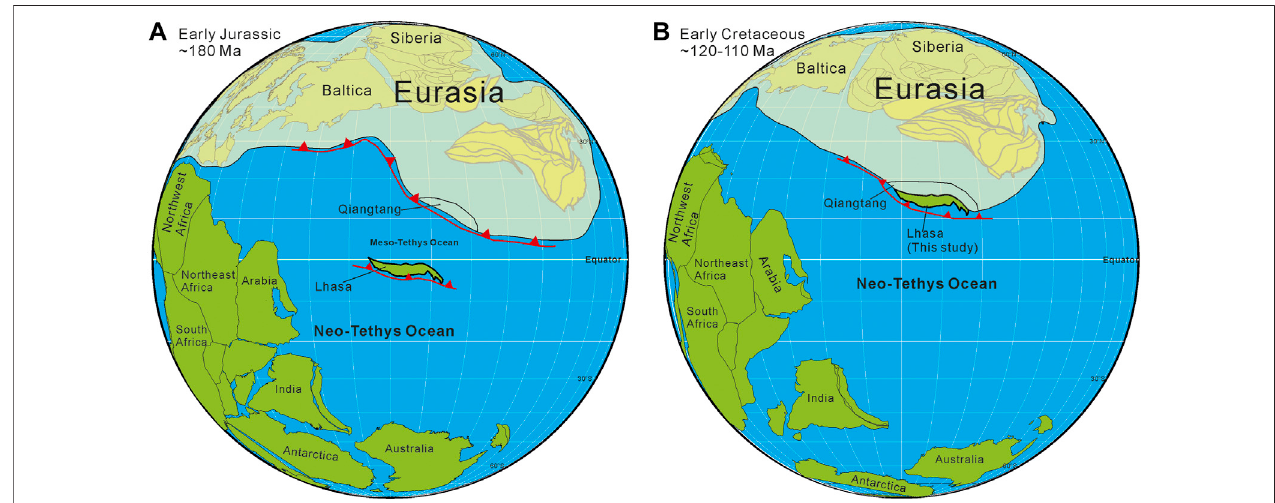
FIGURE 11 | Paleogeographic reconstructions of the Eurasian and Indian continents and the Lhasa terrane at 180 Ma (Early Jurassic) and 120 – 110 Ma (Early Cretaceous), respectively. The paleomagnetic data sets of the Lhasa terrane at 180 Ma and the period of 120 – 110 Ma are from Li et al. (2016) and this study. The data sets for the Africa, India, Antarctica, Australia and Madagascar are from Torsvik et al. (2012). The paleomagnetic data for Asian geological terranes are from Huang et al. (2018).